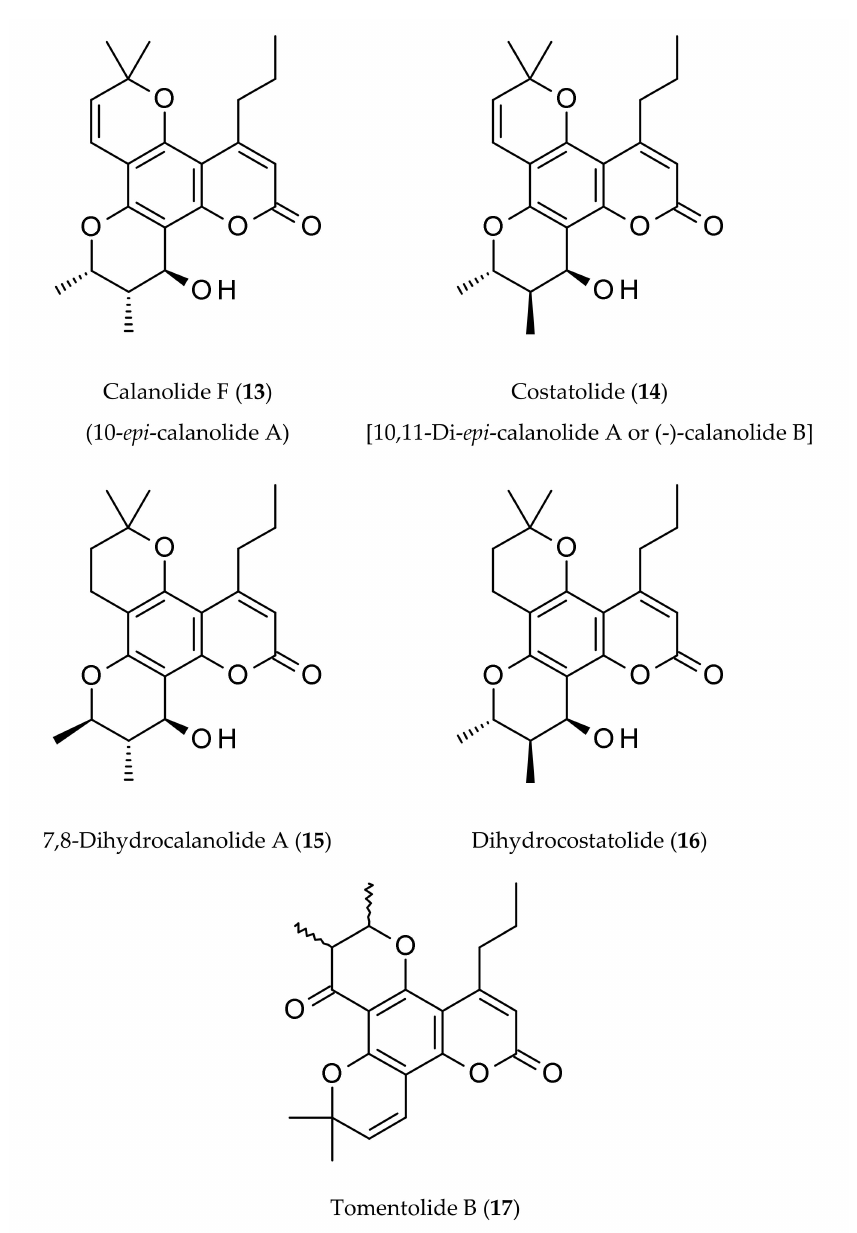
Figure 2. Naturally occurring